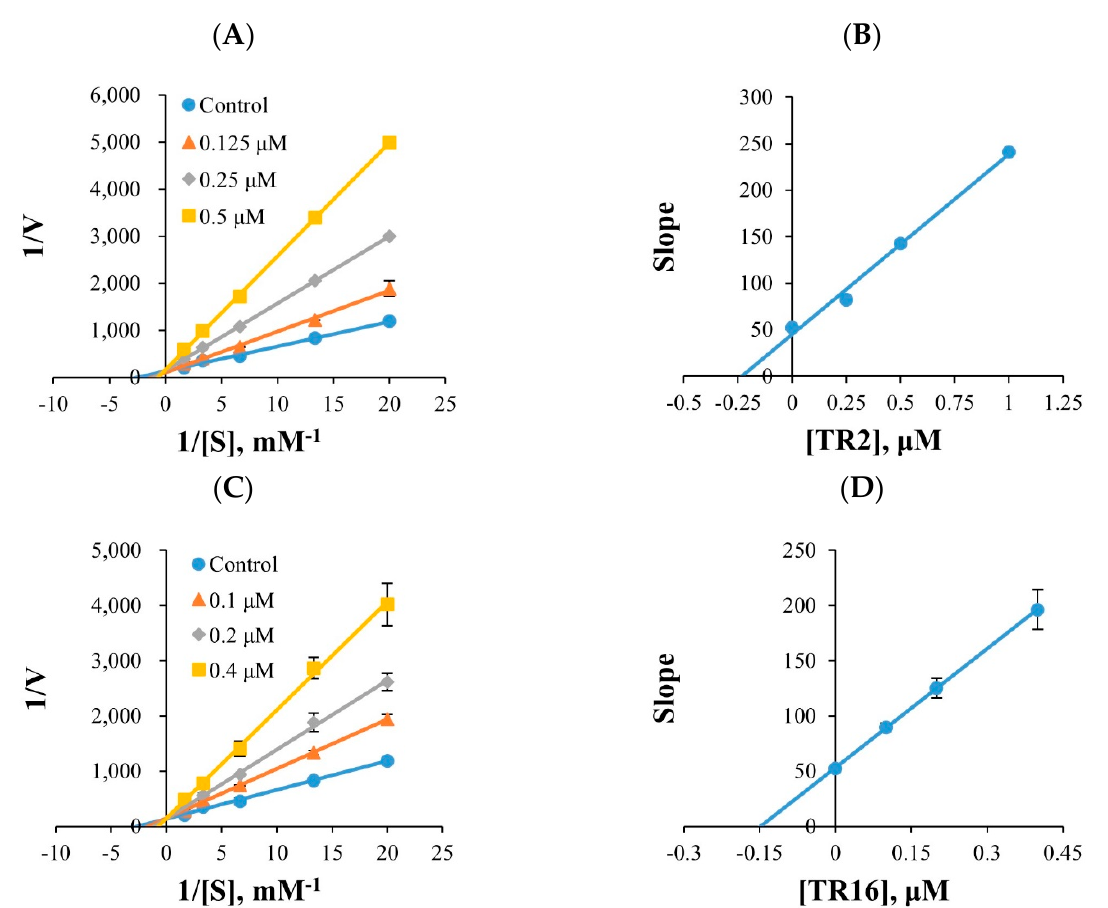
Figure 1. Lineweaver–Burk plots for MAO-B inhibition by TR2 and TR16 ( A , C ), and their respective secondary plots ( B , D ) of slopes versus inhibitor concentrations.